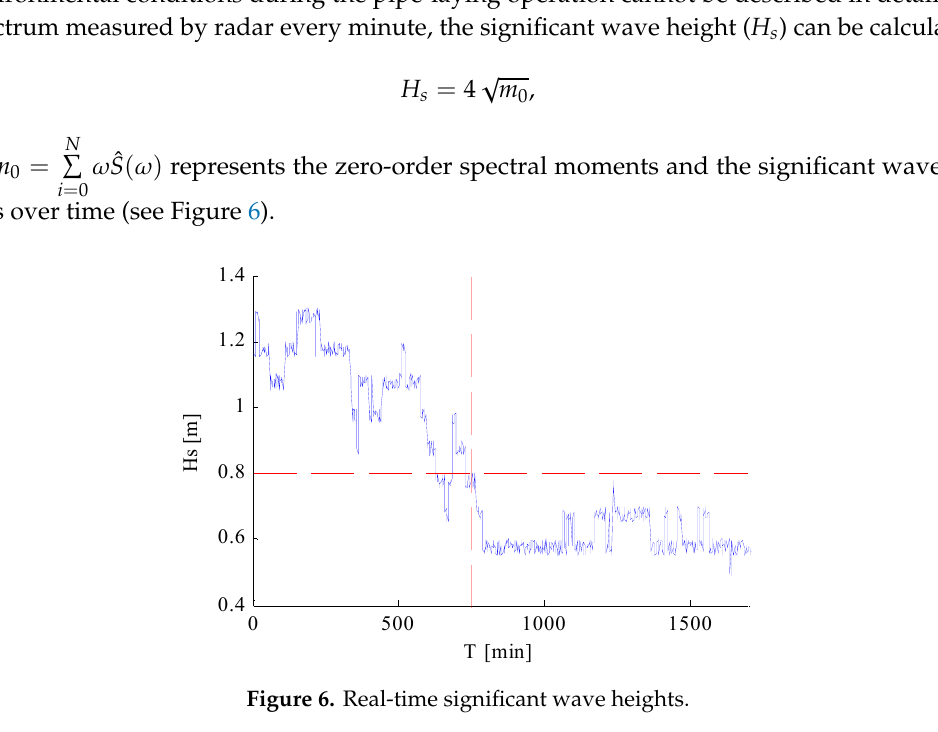
Table 1. Classification of sea states.